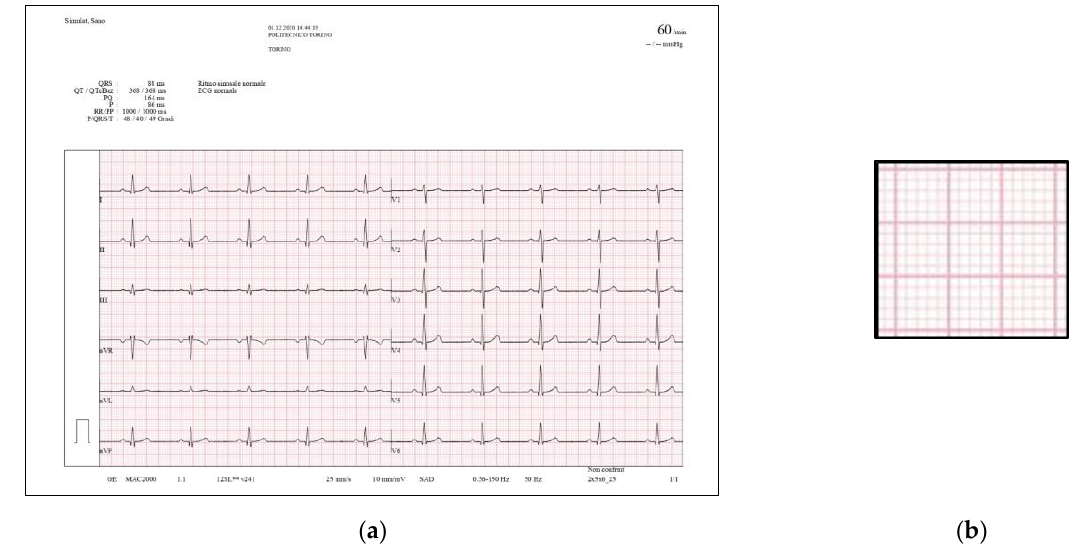
Figure 14. Graph paper with another format, used for reproducibility (normal sinus rhythm, 60 bpm); ( a ) PDF converted to JPEG; ( b ) structure of the grid.